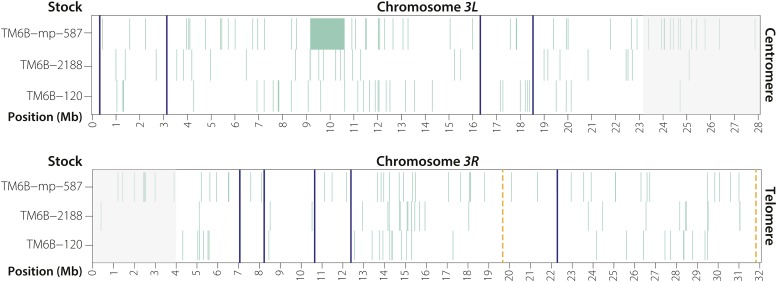
Unique SNPs present among the three TM6B chromosomes sequenced in this study. Gray shaded regions are centromere-proximal heterochromatin with low-quality read alignment. Blue lines indicate the positions of inversion breakpoints, orange dashed lines indicate the approximate positions of the unidentified In(3R)C (92D1-E1;100F2-3) inversion breakpoints. A single DCO event was recovered in stock TM6B-mp-587.